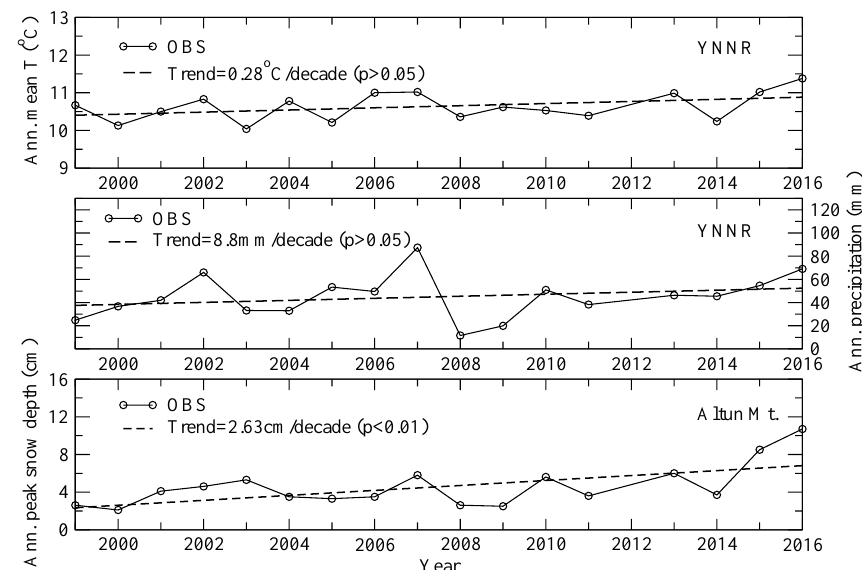
Figure 14. The time series plots and trends of the annual mean temperature ( top ) and annual precipitation ( center ) in the YNNR, and the annual peak snow depth in the Altun Mountains ( bottom ) during 1999–2016. Table 5. The correlation coefficients (r) between the wetland vegetation characteristics at the XTG and WWC and the climatic variables during